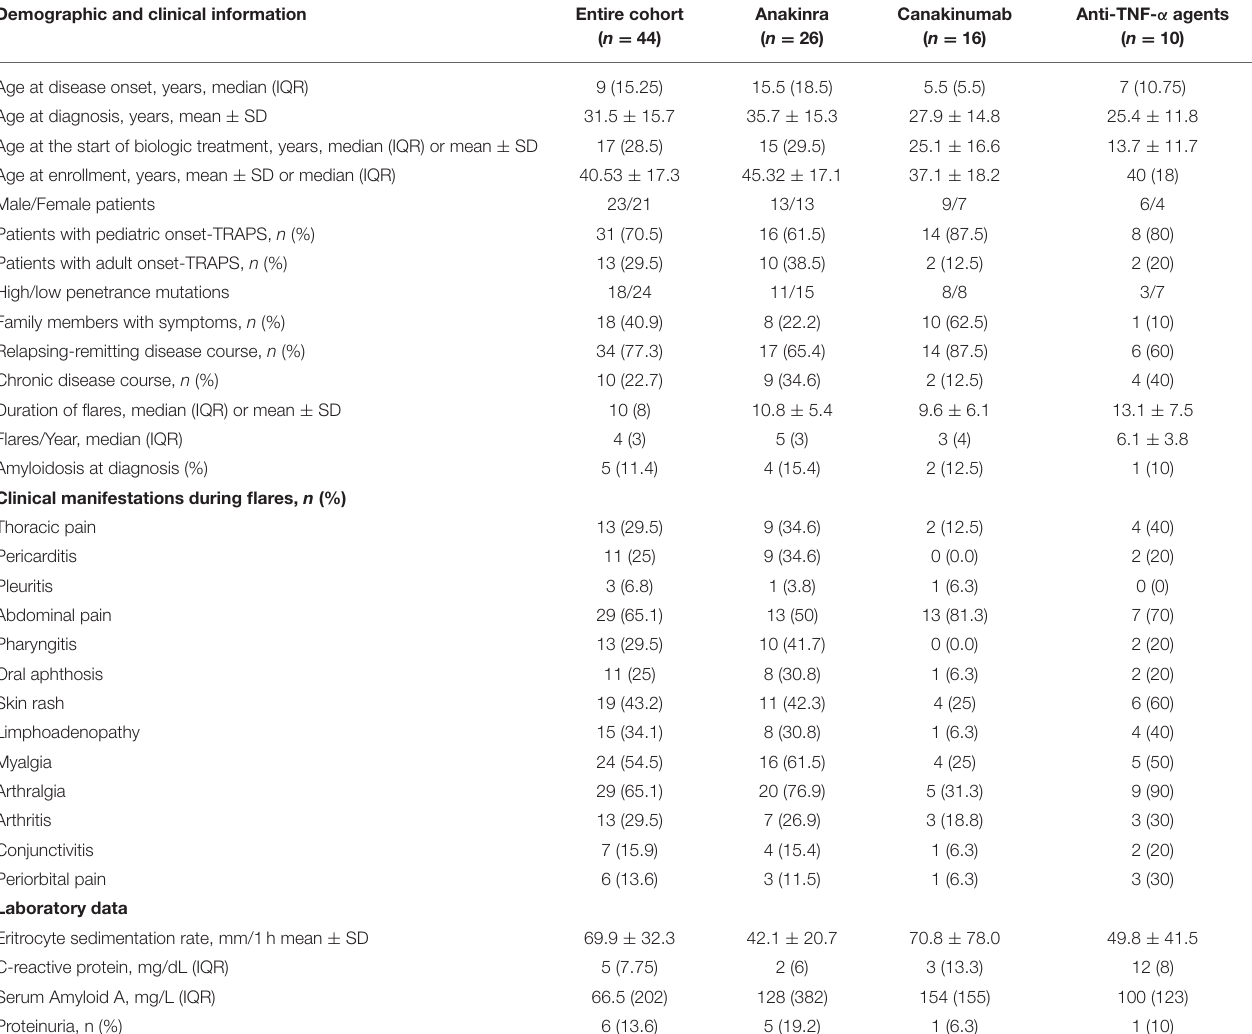
TABLE 1 | Demographic features of patients enrolled; the table also summarizes TRAPS manifestations observed during flares along with laboratory markers recorded at the last flare before starting biologic treatments. Demographic and clinical